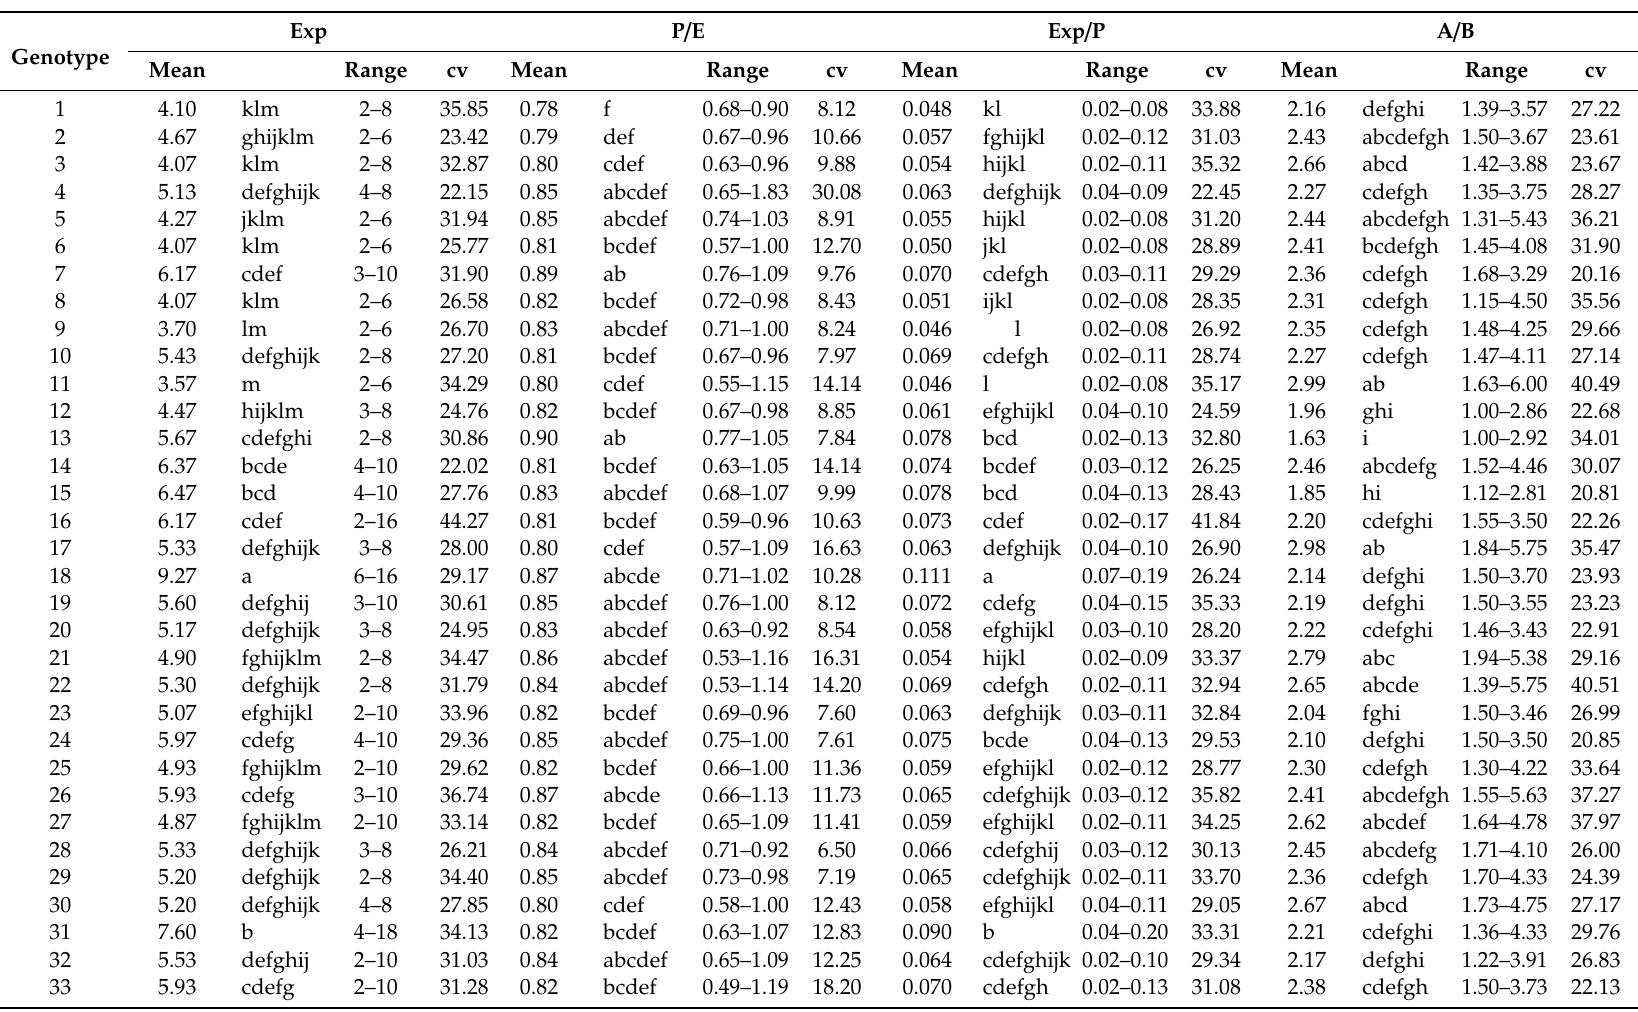
Table 3. Minimal, maximal, and mean values as well as coe ffi cient of variation (cv, in %) for Exp, P / E, Exp / P, and A / B. In columns, means followed by the same letters are not significantly di ff